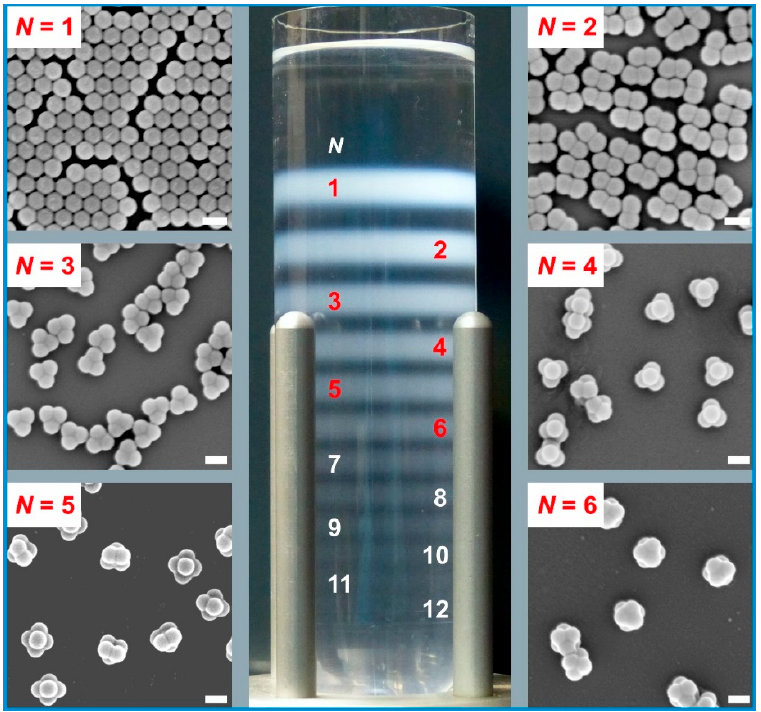
Figure 4. Centrifugal separation of colloidal clusters according to their sedimentation coefficients in a sucrose density gradient ranging from 2% (m/m) to 8% (m/m). The fractionation was carried out in a swing-out rotor at 24,000 rpm. Cluster populations of up to 12 constituent particles were isolated as individual zones that could be harvested by using a self-built fraction recovery unit. FESEM micrographs of fractions of particle monomers ( N = 1), dimers ( N = 2), trimers ( N = 3), tetramers ( N = 4), pentamers ( N = 5), and hexamers ( N = 6) are grouped around the centrifuge tube hosting the gradient and the particle zones. The scale bars represent 200 nm.